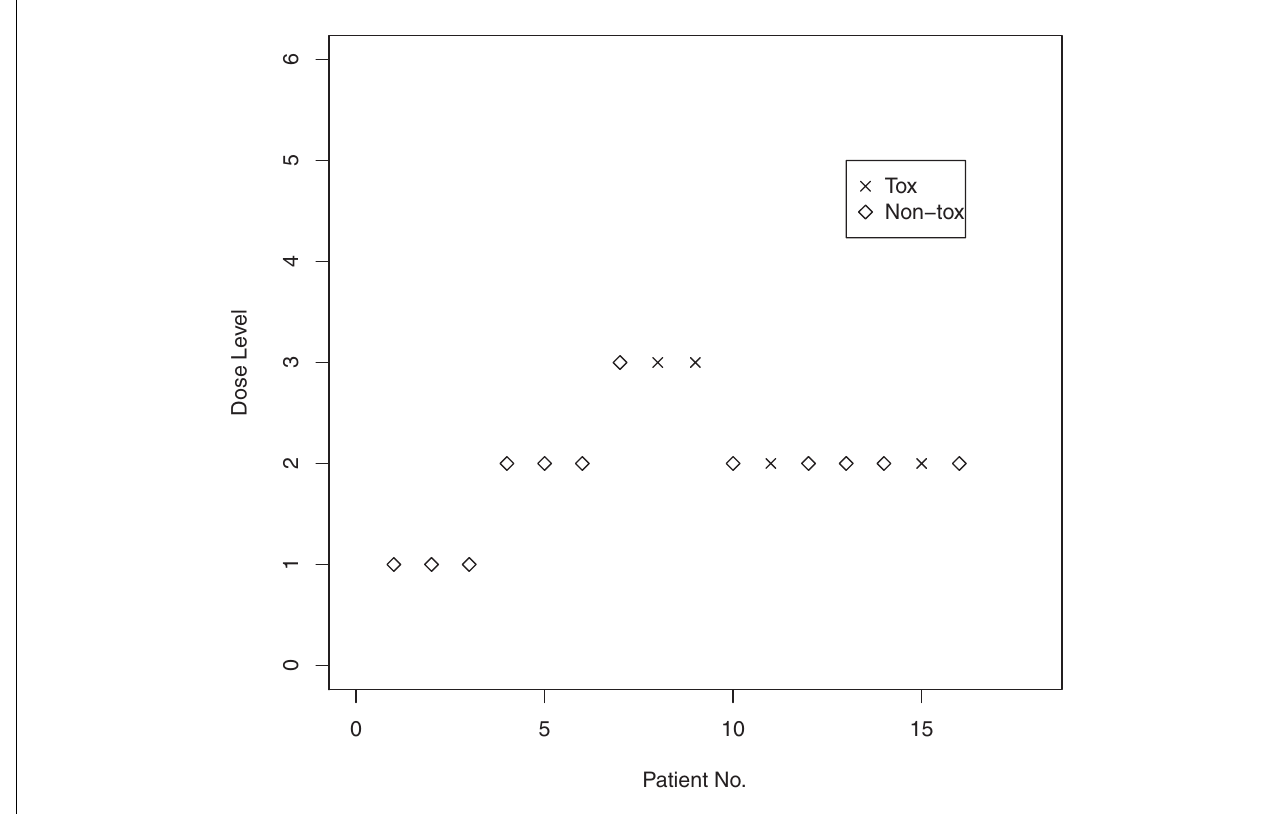
FIGURE 1 | Results from a simulated Phase I trial using the continual reassessment